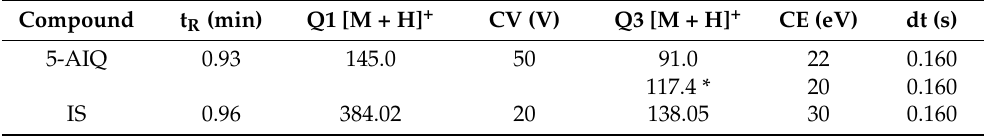
Table 1. Optimized UPLC-MS/MS parameters for 5-AIQ and IS.